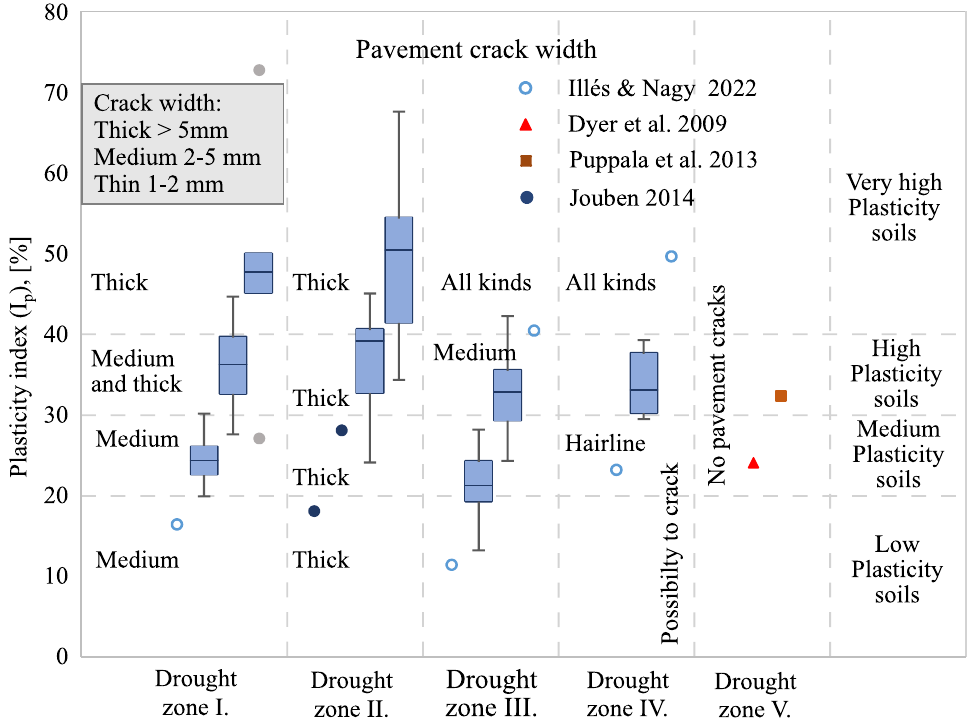
Fig. 15 Drought zones (I. to V.), soil plasticity of the embankment and pavement